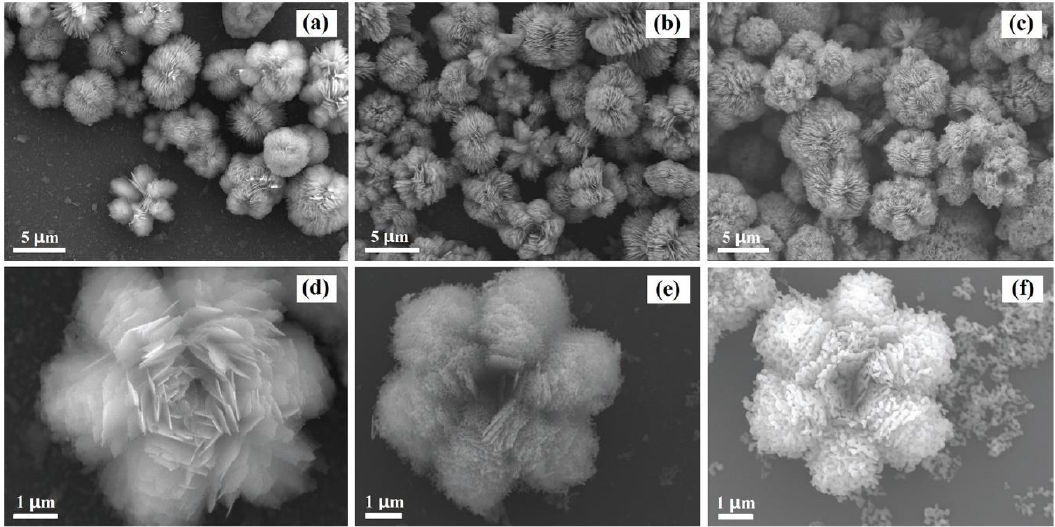
Figure 23. SEM images of the flower-like ZnO soaked at different temperatures: 400 °C ( a , d ), 500 °C ( b , e ), 600 °C ( c , f ). Reprinted from [654], Copyright (2014), with permission from Elsevier [OR APPLICABLE SOCIETY COPYRIGHT OWNER]. All rights reserved. In order to re-use permission must be obtained from the rightsholder.